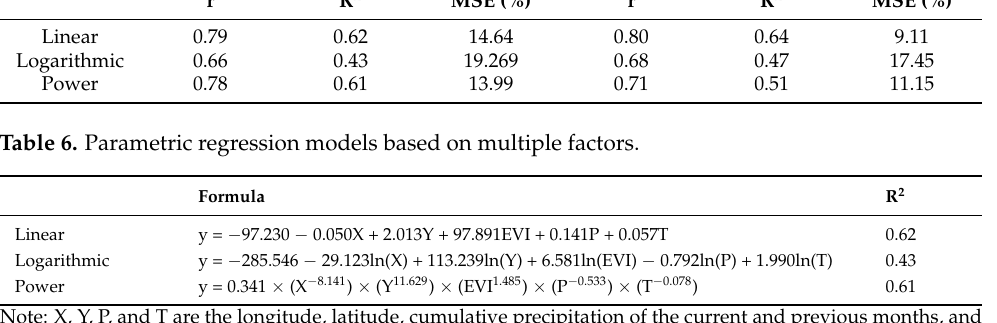
Table 6 lists the accuracy evaluation results of the SVM and BPNN regression